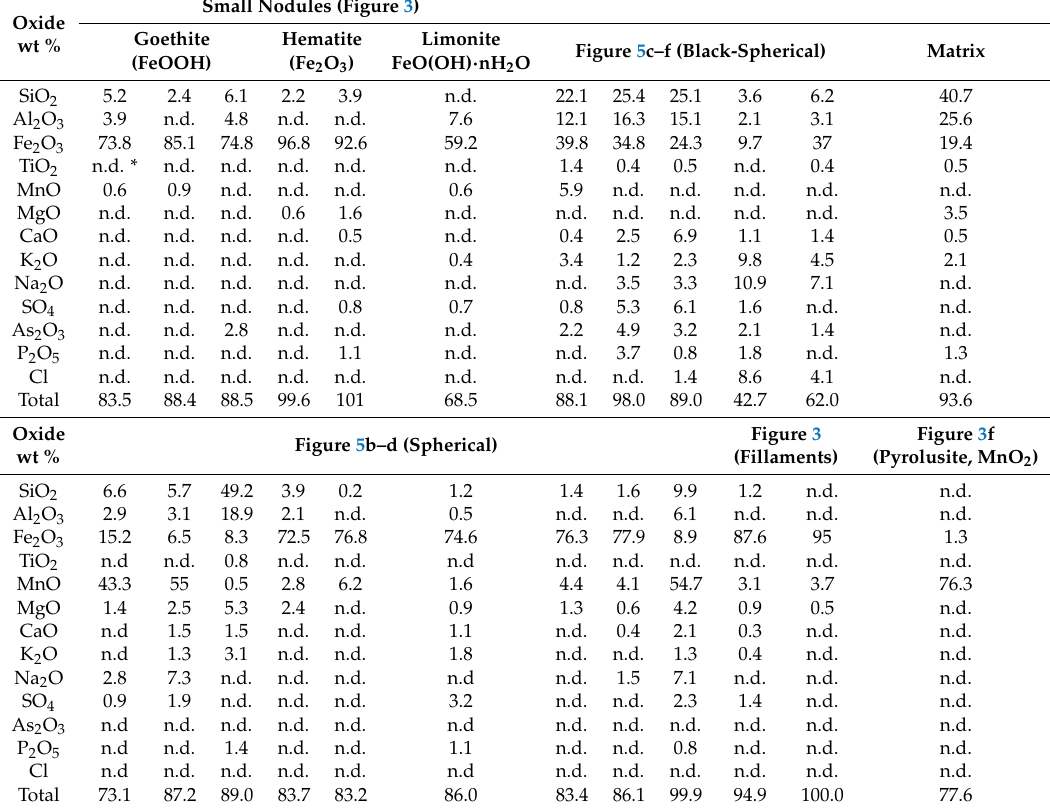
Table 2. Representative scanning electron microscope (SEM)-energy dispersive spectroscopy (EDS) analyses from the Fe-Mn-mineralization at the Legrena valley, Lavrion. Small Nodules (Figure 3) Oxide wt % Figure 5c–f (Black-Spherical) Matrix